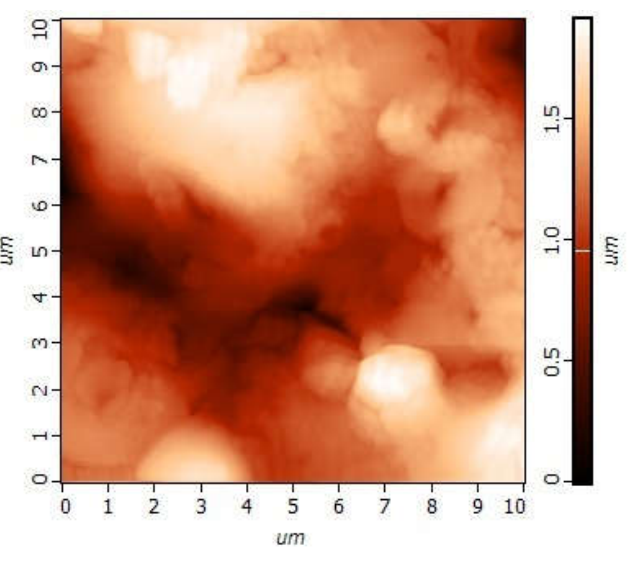
Figure 6. AFM image of the CP surface.